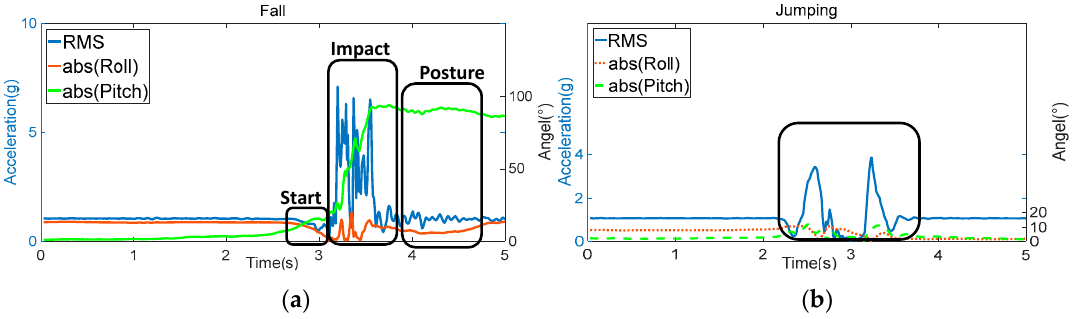
Figure 7. RMS, roll, and pitch during falling and activities of daily living (ADL): ( a ) forward fall ending up lying; ( b ) jumping.